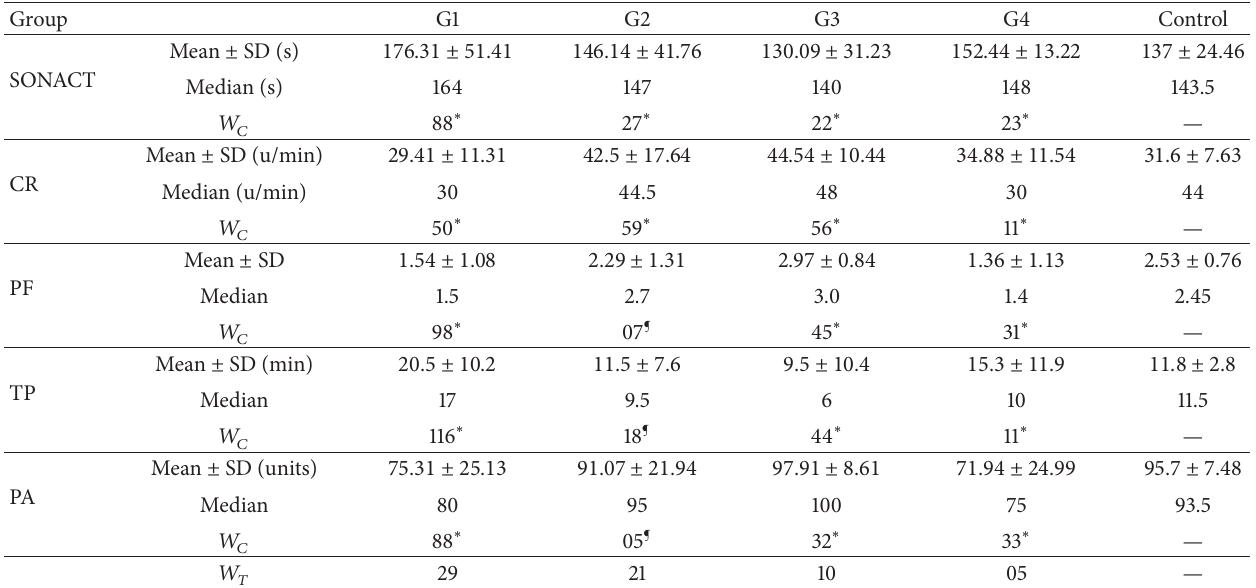
Table 2: Comparison between sonoclot parameters in different groups.